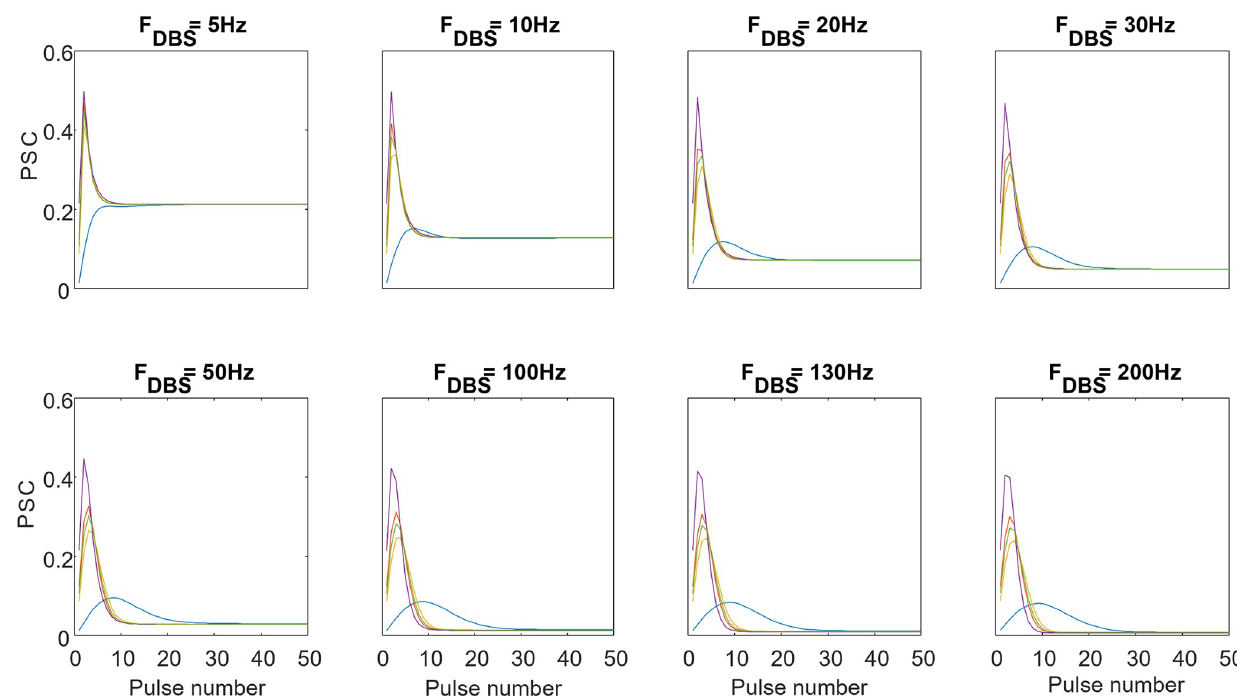
Fig 3. Mismatch of the transient PSCs in spite of similar steady-state responses. Each color indicates a specific type of STP and each panel represents PSC response to an individual stimulation frequency. Although the steady-state PSCs of the STP types are similar at all illustrated stimulation frequencies, the transient phases are remarkably different due to variations in the parameters